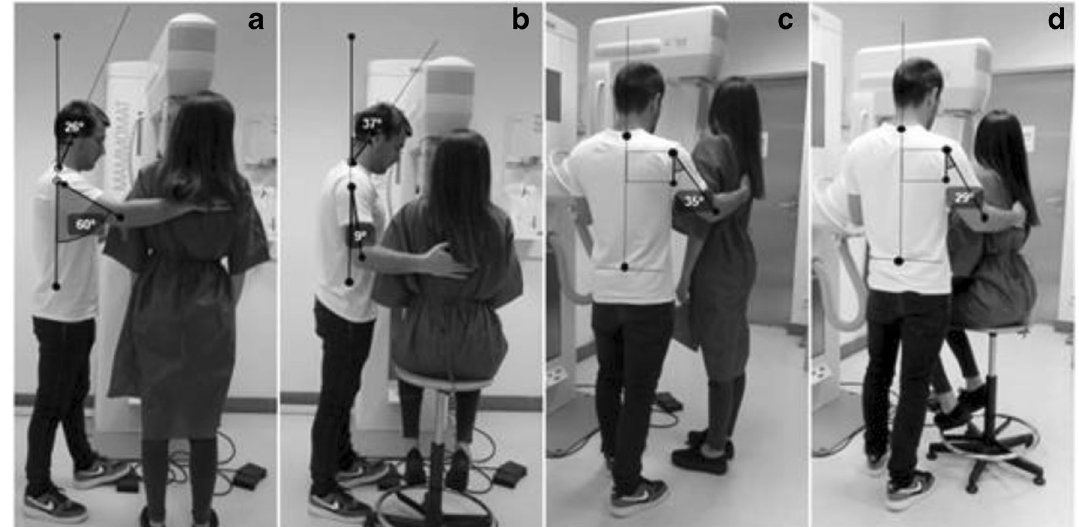
Fig. 1 CC breast positioning: a and c radiographer postures without intervention; b and d alternative postures when the radiographer and patient have identical